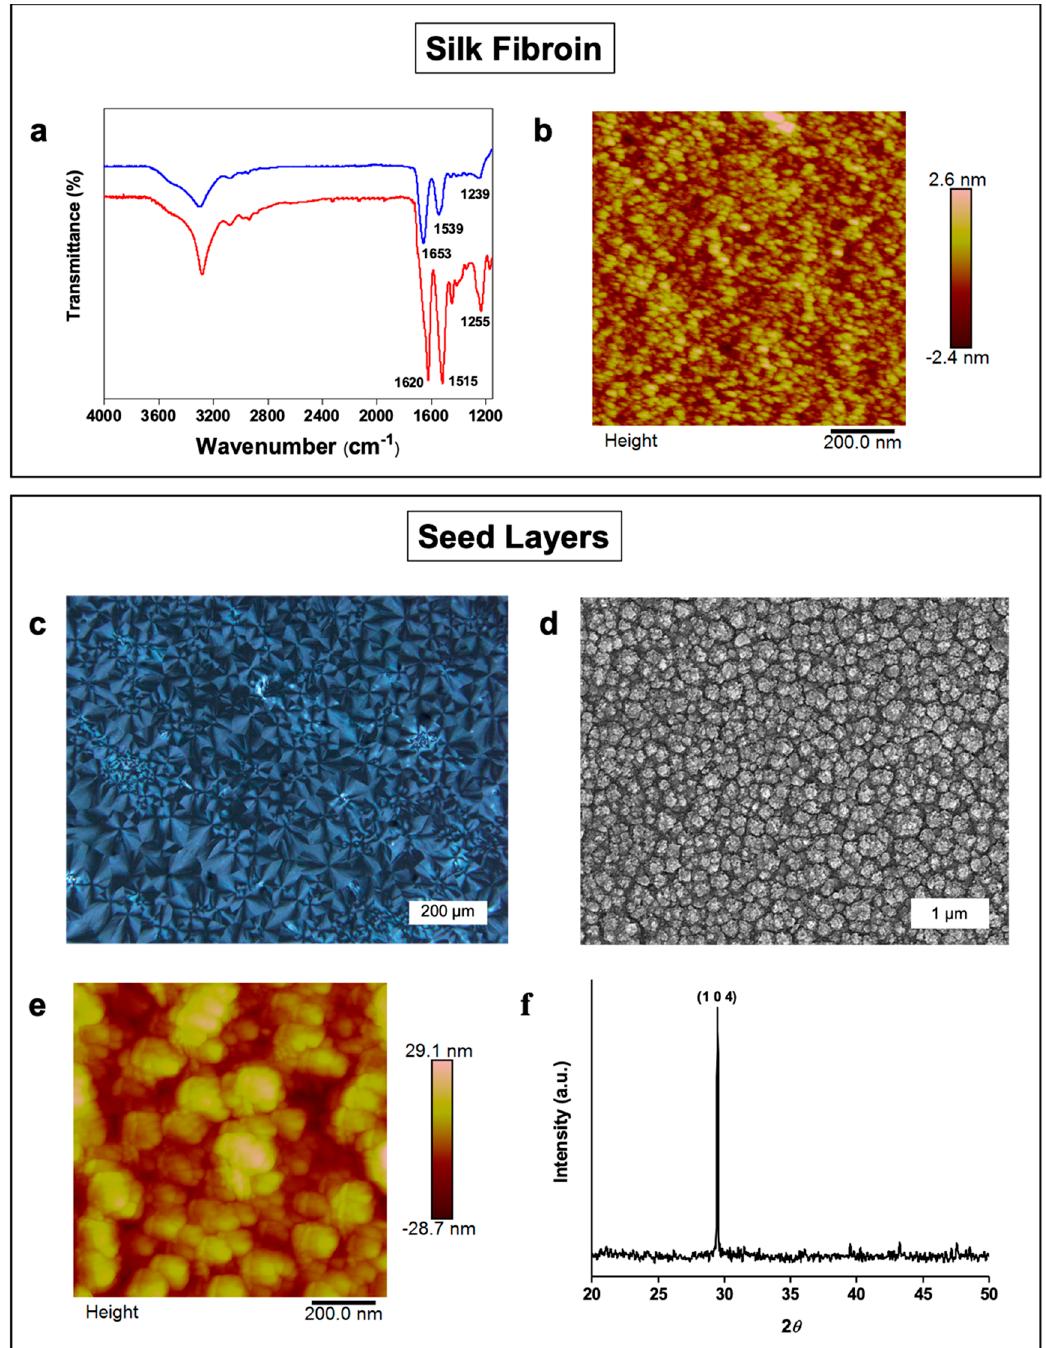
Figure 1. Characterization of SF matrices and seed layers. ( a ) Fourier transform infrared (FT-IR) spectra of SF matrices with (red) and without (blue) ethanol treatment. ( b ) atomic force microscopy (AFM) image of an SF matrices after ethanol treatment. ( c–f ) polarized optical microscopy (POM) ( c ), SEM ( d ), AFM ( e ), and XRD pattern ( f ) of CaCO 3 -PAA seed layers.